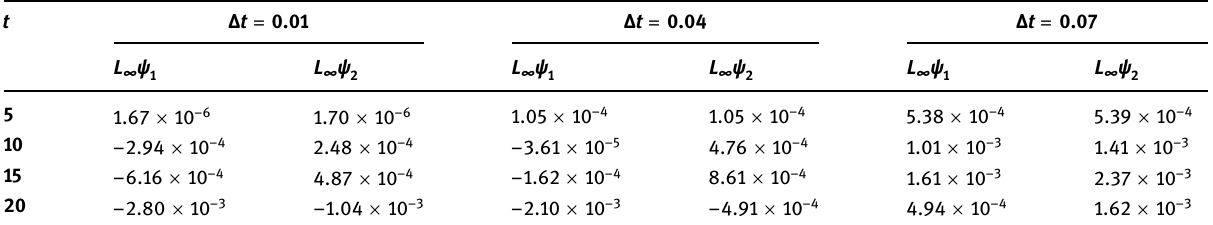
Table 5: L ∞ error for two - soliton interaction for parameters = N 201 , di ff erent time levels,